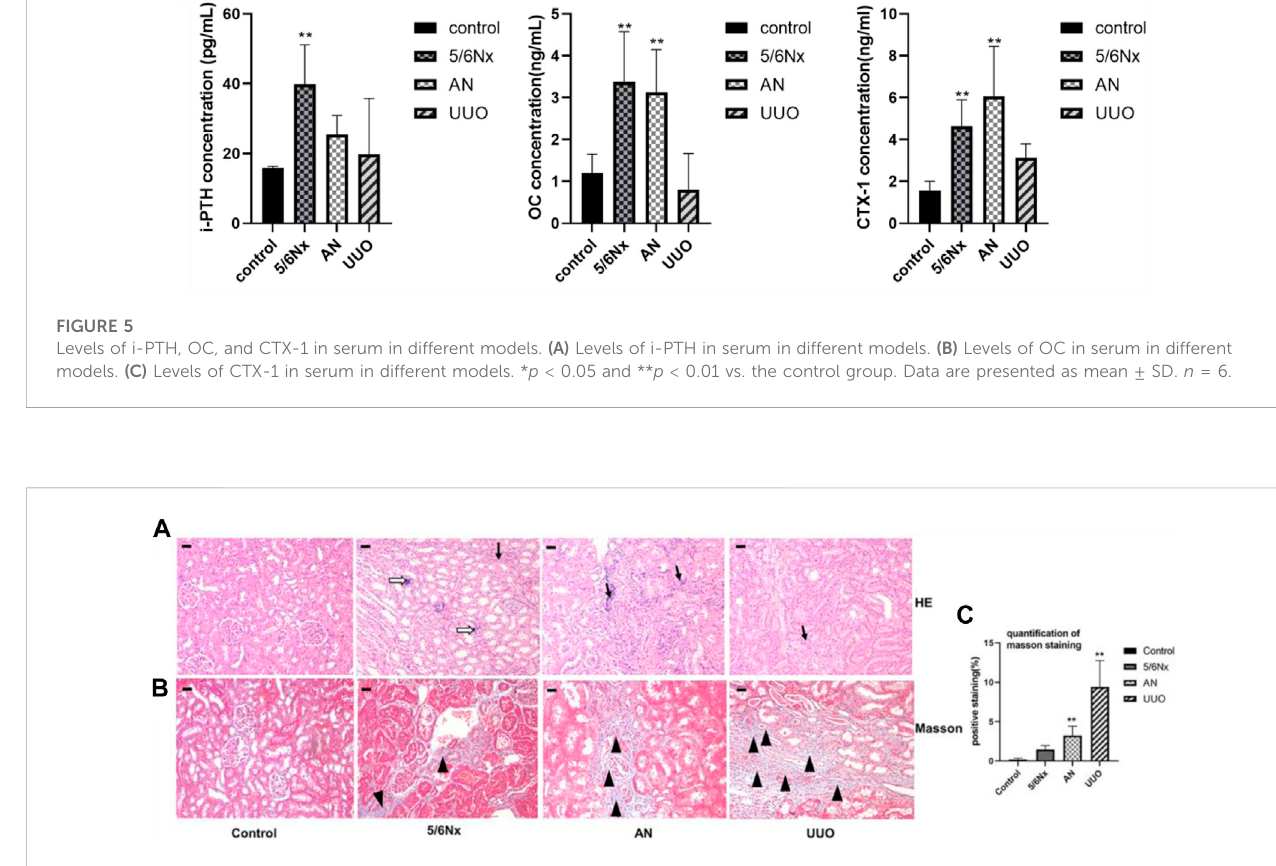
Histopathological analysis of kidneys in different models. (A) Representative images of HE staining; × 100, scale bar = 10 μ m. Chronic in fl ammatory cell in fi ltration: black arrow; focal calci fi cation: white hollow arrow. (B, C) Representative images of Masson ’ s staining for the assessment of fi brosis showing signi fi cant differences in the degree of fi brosis (expressed as the percentage of the positively stained area). × 100, Scale bar = 10 μ m, renal interstitial fi brosis: black triangle. N =